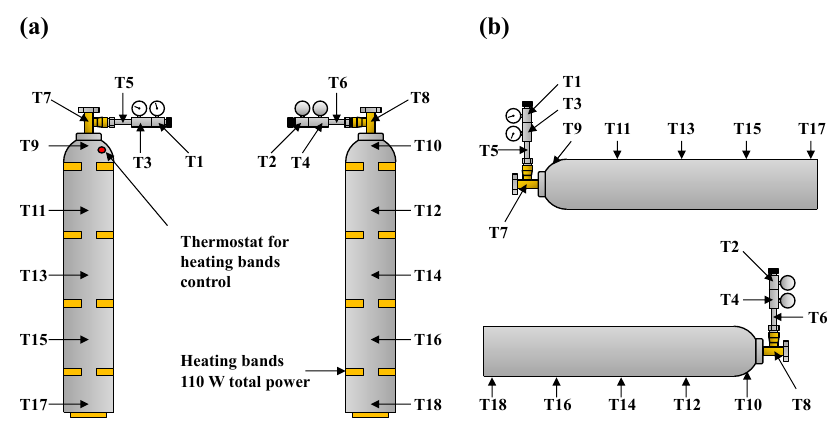
Figure 5. Schematic of the locations of the thermistors on the cylinder in vertical (a) and horizontal position (b) as well as the heating bands if used. Thermistors 19 to 25 were bundled and used to measure the background temperature of the